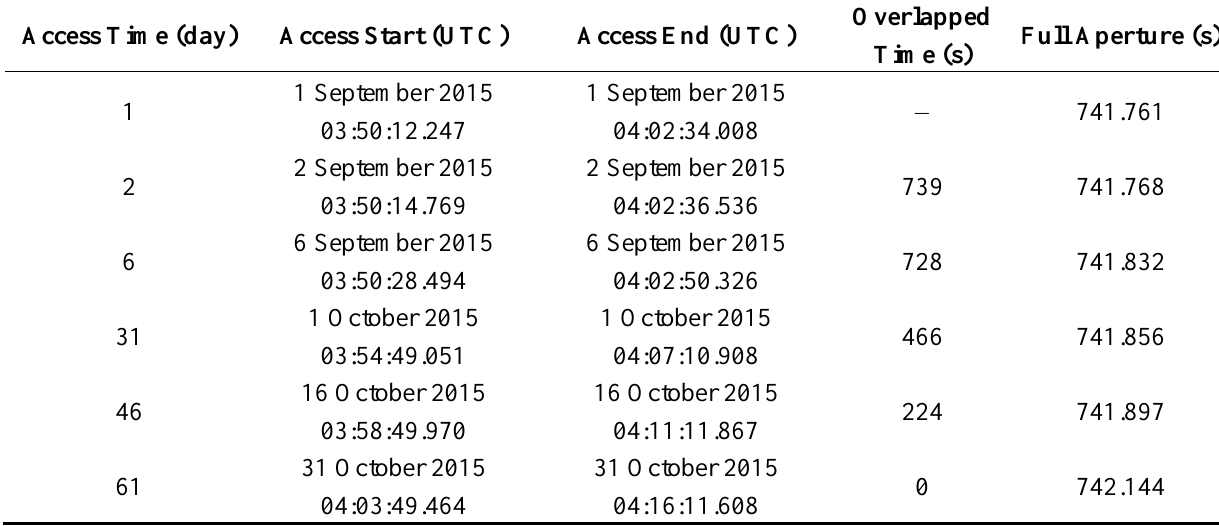
Table 4. GEO SAR coverage time analysis of a target by Systems Tool Kit